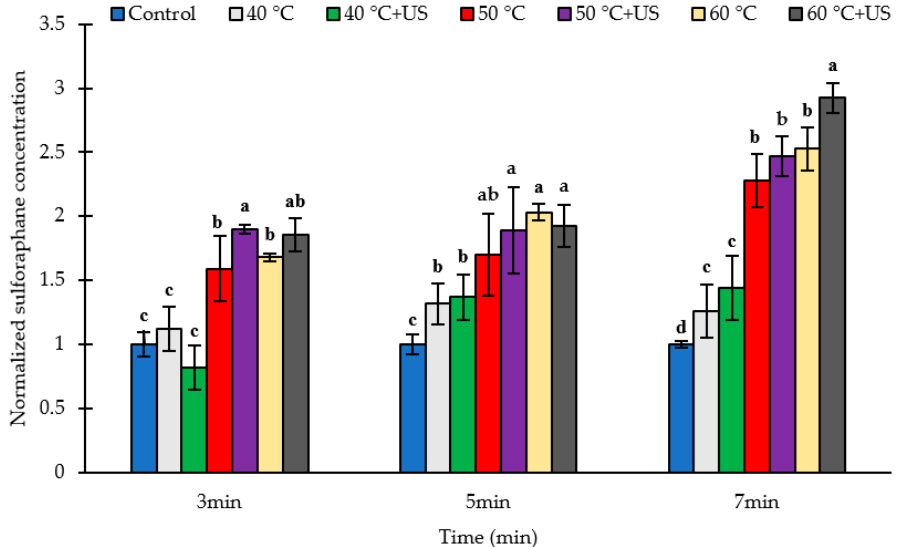
Figure 3. The normalized sulforaphane yield (Sulforaphane content in treated sample/sulforaphane content in untreated control) in broccoli puree after thermal/thermosonication pre-treatments of broccoli floret. Letters above each bar indicate the results of Duncan’s test; Different letters within the same group indicate significant difference ( p < 0.05).